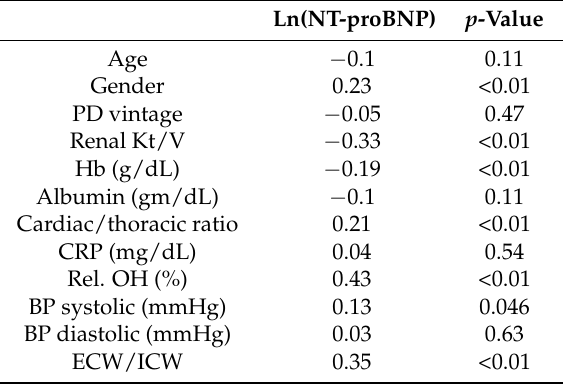
Table 2. Correlations between NT-proBNP levels and other clinical